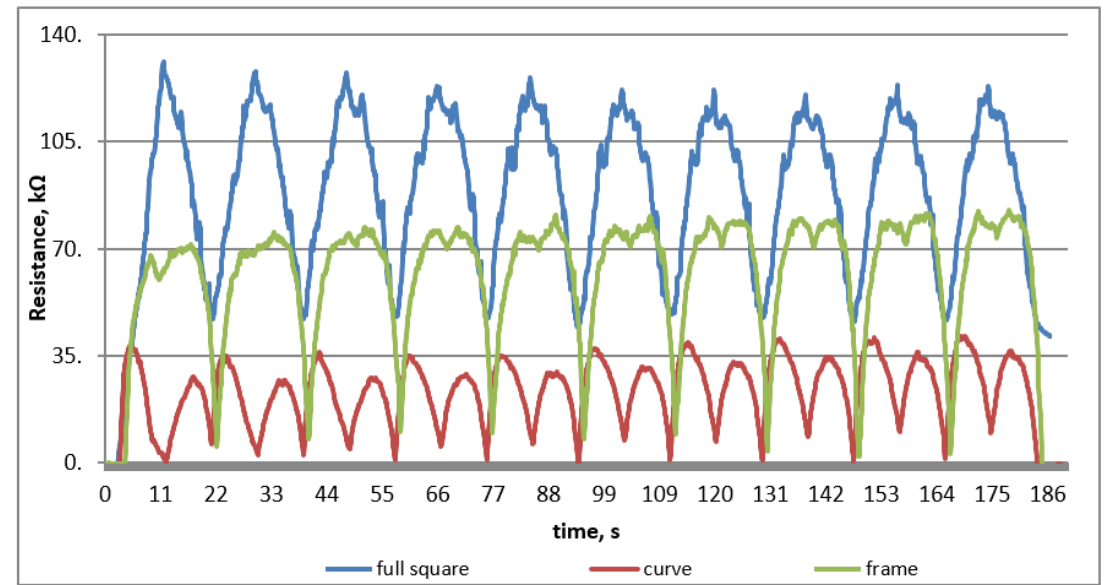
Figure 2. The course of resistance changes during the sensory sensitivity test. Sensors 2020 , 20 , x FOR PEER REVIEW